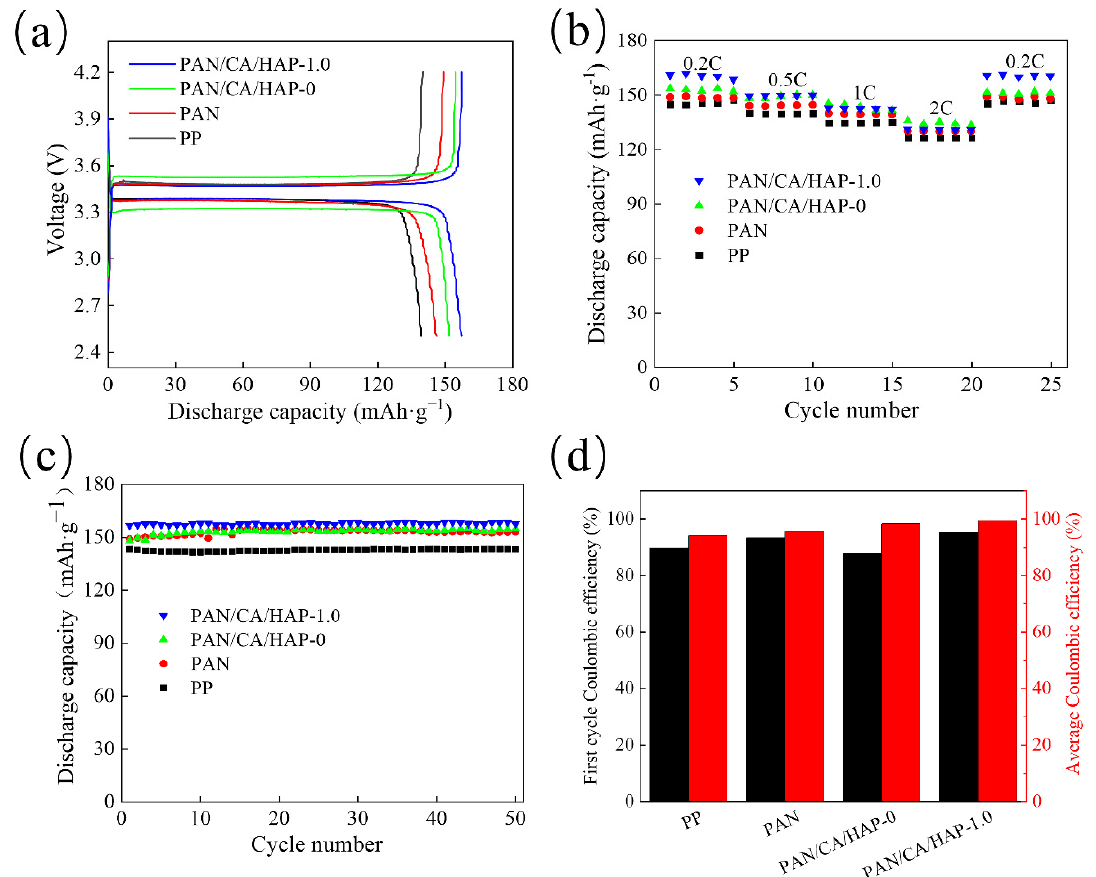
Figure 10. ( a ) Initial charge/discharge (0.2 C/0.2 C); ( b ) Rate performance (0.2 to 2 C); ( c ) Cycle performance (0.5 C); ( d ) Coulombic efficiency values of cycle test.